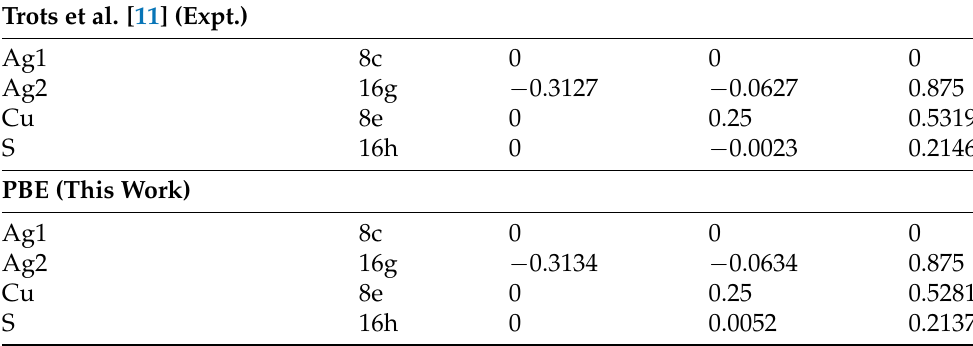
Table 1. Atomic positions in Ag 3 CuS 2 (I4 1